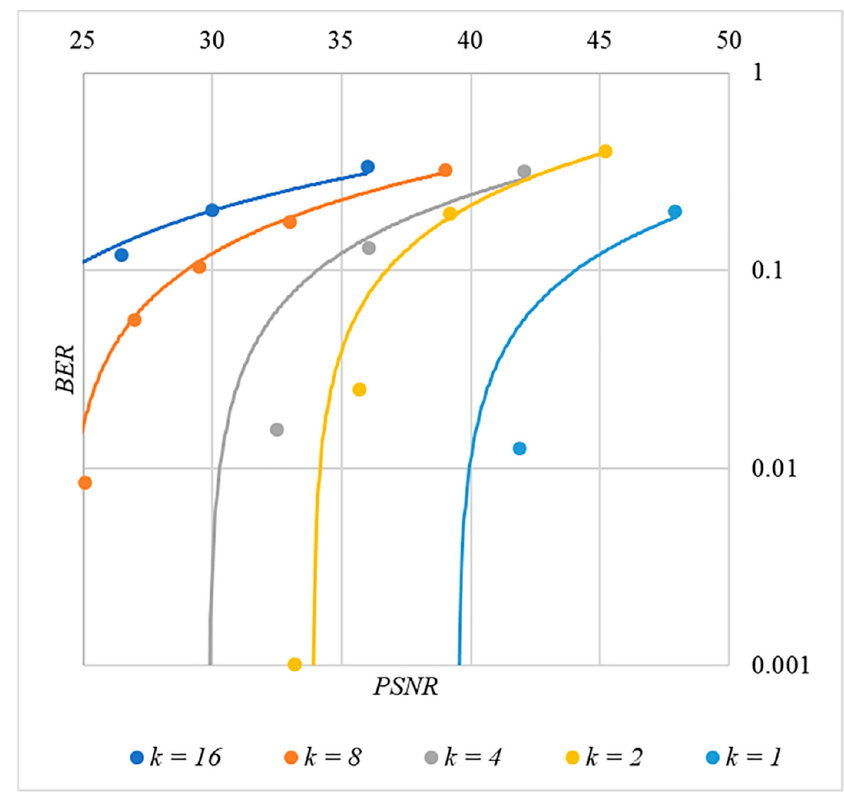
Figure 15. BER ( PSNR ) dependencies for different values k rule for generating chip codes № 3.